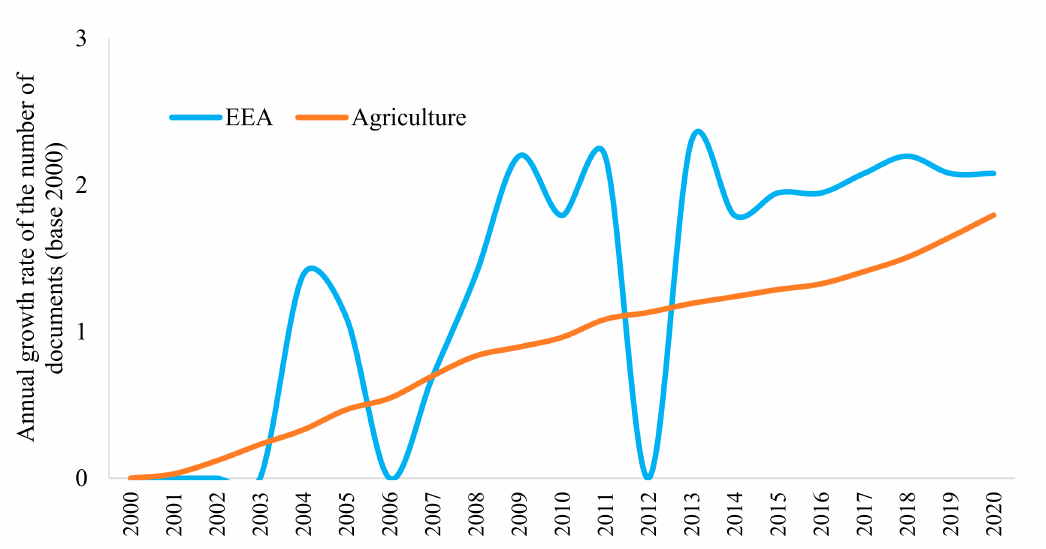
Figure 2. Comparative trends between EEA and agriculture research.